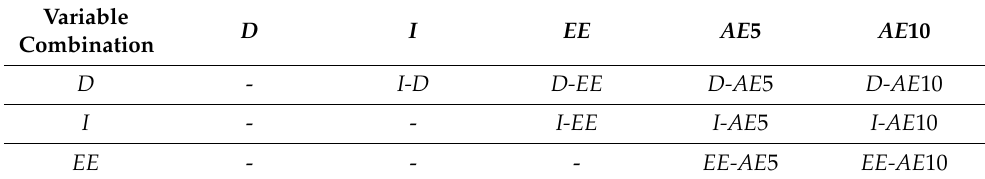
Table 2. Possible combinations of rainfall